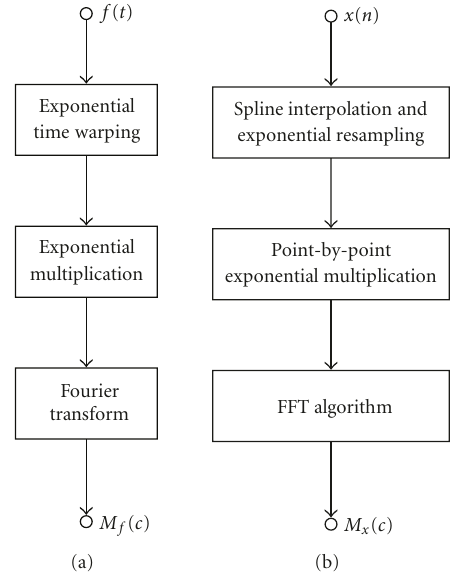
Figure 1: Block diagram of the fast Mellin transform idea (a) and the relative implementation blocks